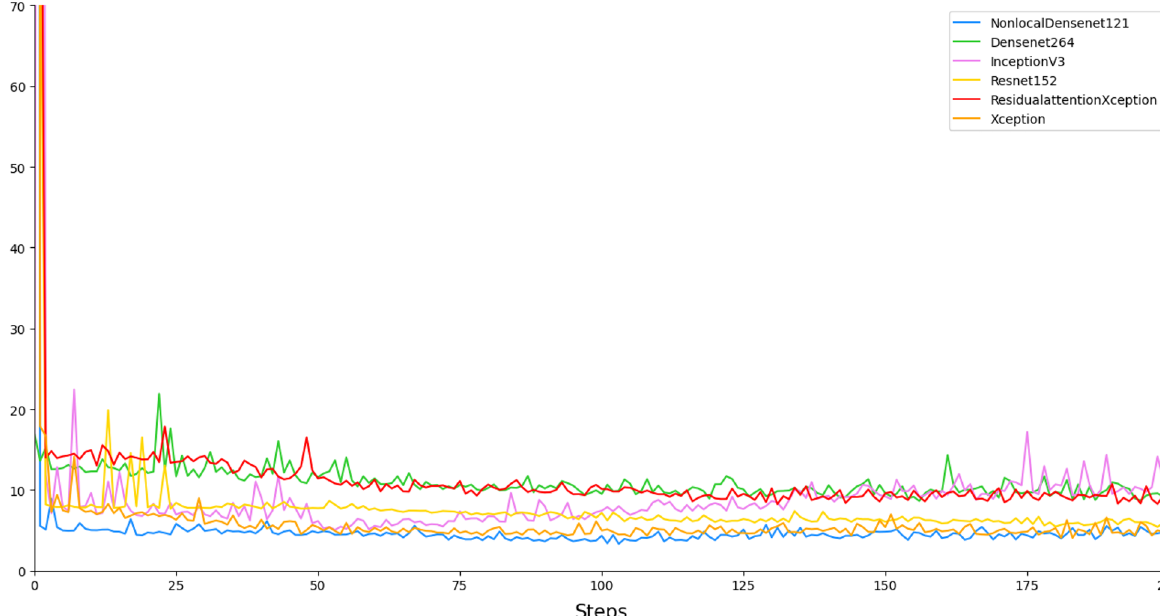
Figure 7. Loss function for each model.